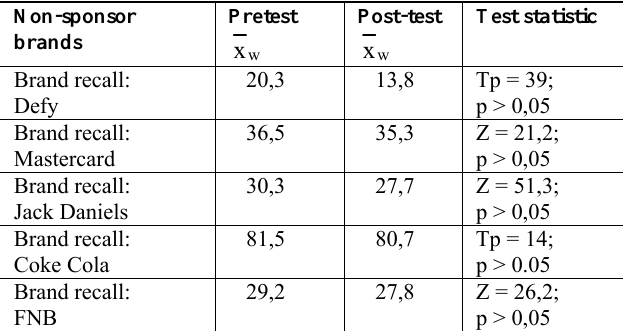
Table 3: Brand recall: non-sponsor